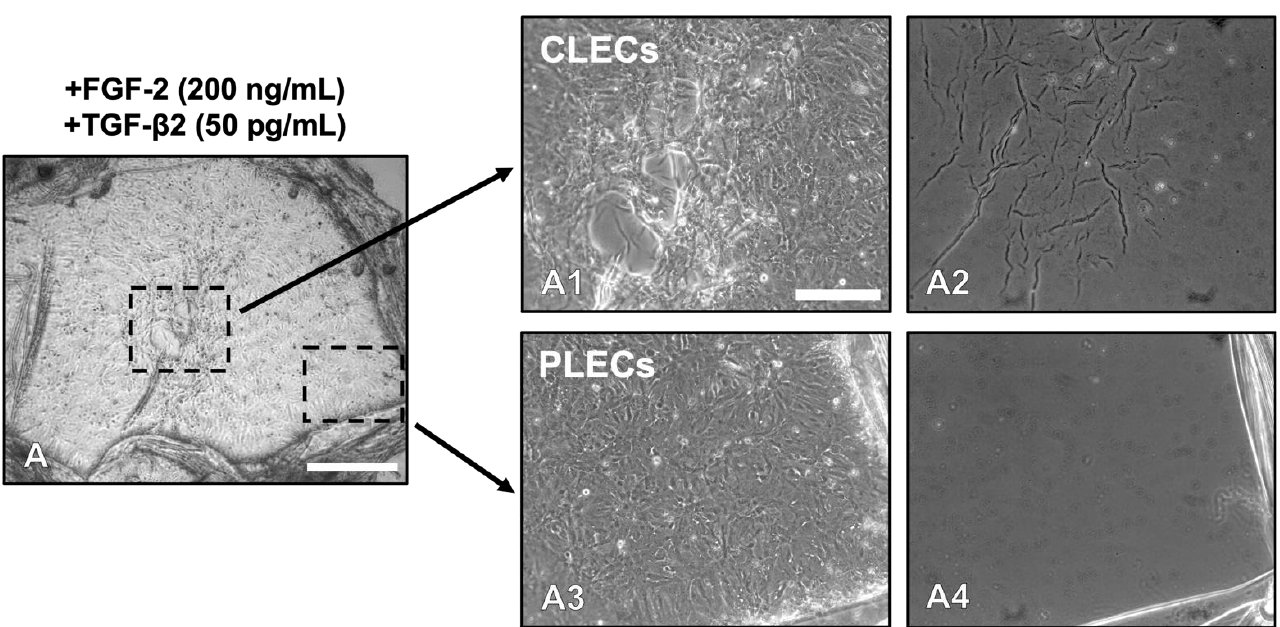
Figure 2. Lens capsule modulation during TGF- β2 -induced EMT . Seventy-two h post treatment, the explants were rinsed consecutively in filtered Milli-Q H 2 O to remove all lens epithelial cells and view the underlying lens capsule. In the F/t cotreated explants ( A , A1 , A3 ), after cell removal ( A2 , A4 ), capsular wrinkling was only apparent in regions that were previously populated with CLECs ( A2 ), with no wrinkling visible in regions that were previously populated with PLECs ( A4 ). Scale bar: 400 µm ( A ), 200 µm ( A1 – A4 ).